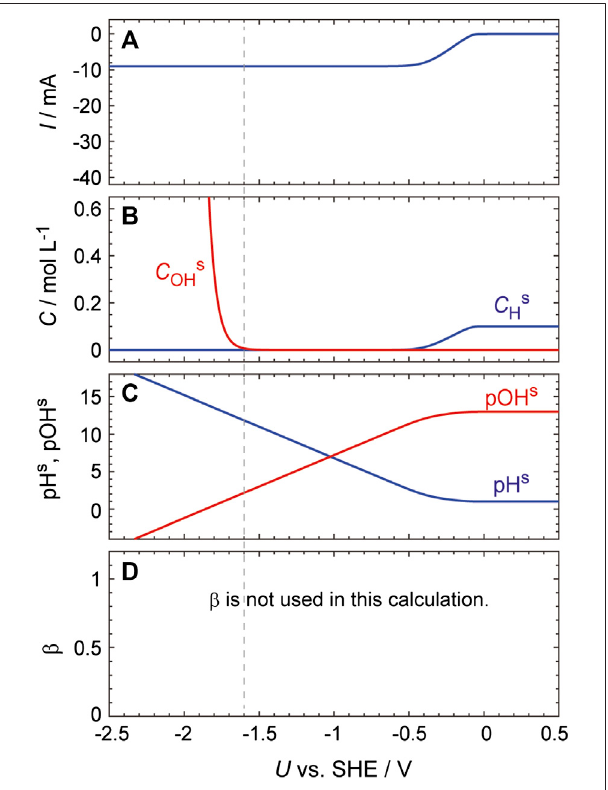
FIGURE 6 | Simulated curves generated with U being scanned at a rate of 0.01 Vs − 1 from 0.5 V. The parameter values used were: C Hb (cid:2) 1.0 × 10 – 4 mol cm − 3 , δ (cid:2) 0.01 cm, T (cid:2) 300 K , N 0 (cid:2) 2.2 × 10 – 9 mol cm − 2 , C DL (cid:2) 2.0 × 10 – 5 F cm − 2 , A (cid:2) 0.1 cm 2 , R Ω (cid:2) 20 Ω , E 20 (cid:2) E − 20 (cid:2) − 0.08 V vs.